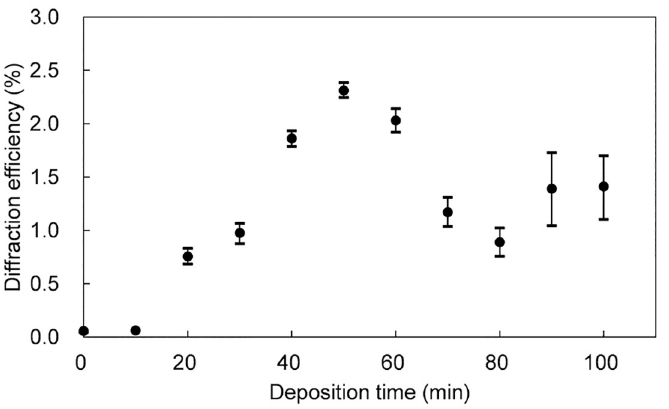
Fig 4. Diffraction efficiency as a function of the deposition